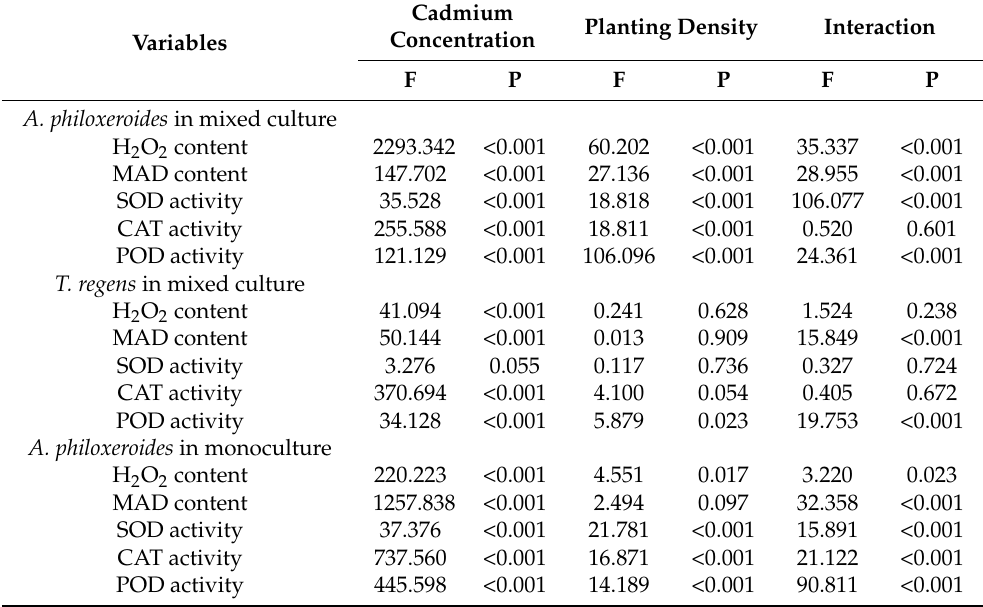
Table 2. F-values and significance levels for factorial ANOVA of the effects of density and cadmium on enzyme activity of A. philoxeroides and T. regens . Cadmium Planting Density Concentration Variables